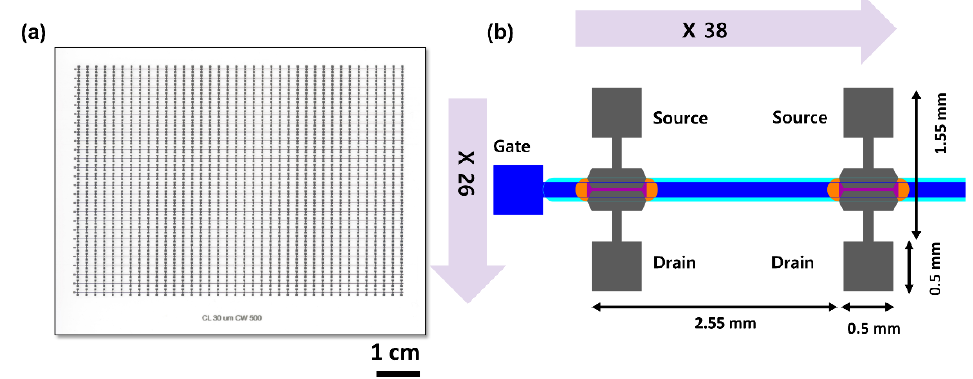
Figure 1. ( a ) Diagram of the 26 × 38 SWCNT-TFT array. ( b ) Enlarged view of a single TFT in the array.